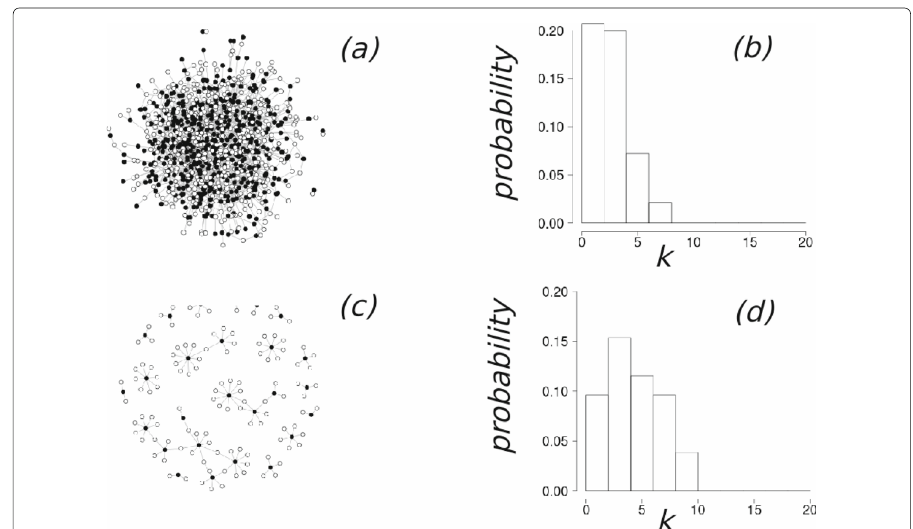
Fig. A.3 Realization of a system with N = 1000 agents and Erdos-Renyi contact network of mean degree < k > = 6. Figures correspond to two values of the parameter ρ . Up: early times ρ = 0.49; Down: times close to convergence ρ = 0.04. Left panel a , c : snapshots of G AL . Right panel b , d : degree distribution of the corresponding graph G AL